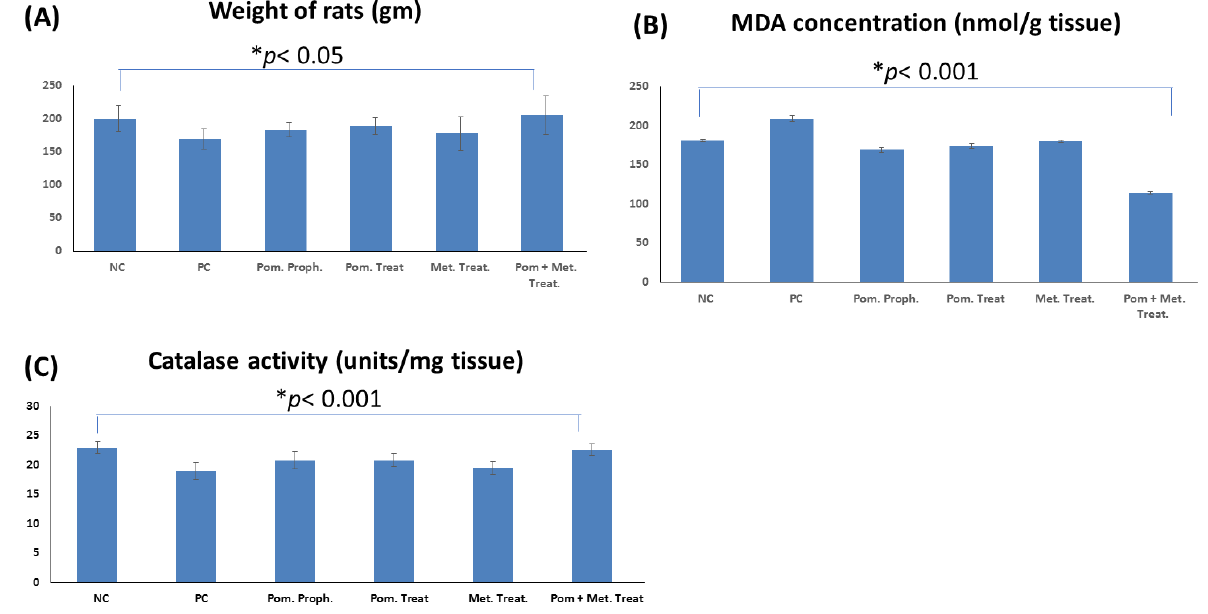
Figure 5. Effect of H. pylori infection, pomegranate extract (PEAME), and metronidazole on the weight of rats ( A ), malodialdehde (MDA) concentration in stomach tissue ( B ), and catalase activity in stomach tissue ( C ). Data are presented as mean ±SD, n = 8, significance level p < 0.05. NC: negative control (not infected), PC: positive control (infected with H. pylori ), Pom proph.: PEAME prophylactic group, Pom treat.: PEAME treated group, Met. Treat.: metronidazole treated group, Pom + Met treat.: rats co-treated with PEAME and metronidazole.